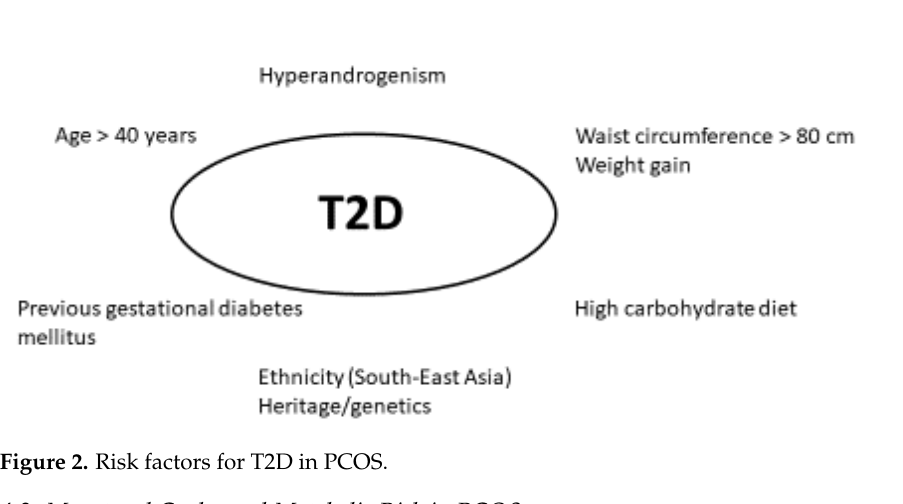
Figure 2. Risk factors for T2D in